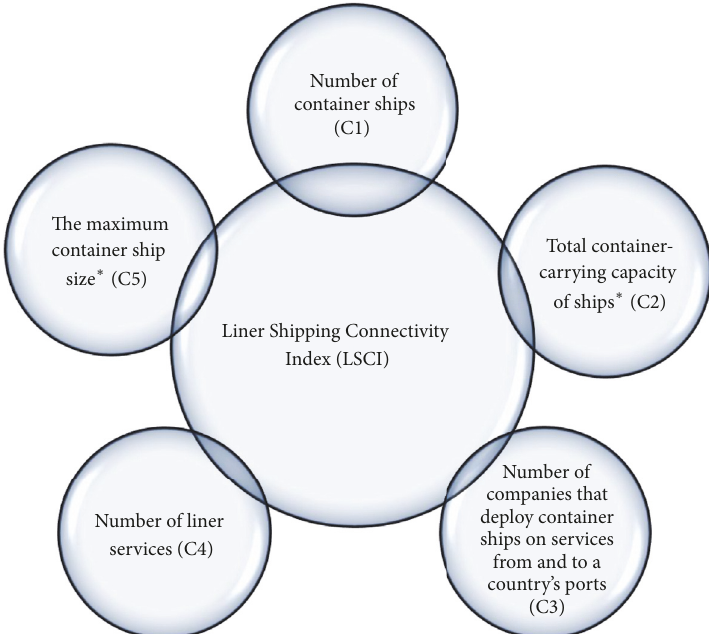
Figure 10: Components of LSCI. ∗ : unit is TEU.